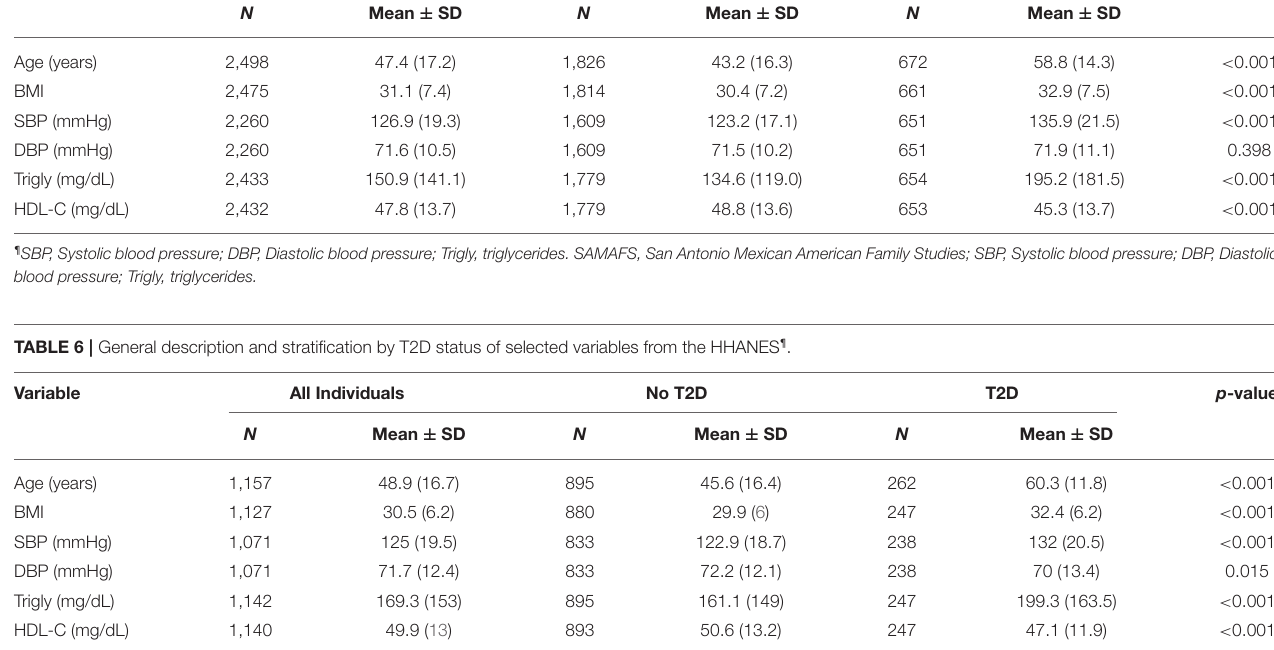
TABLE 5 | General description and stratification by T2D status of selected variables from the SAMAFS ¶ . Variable